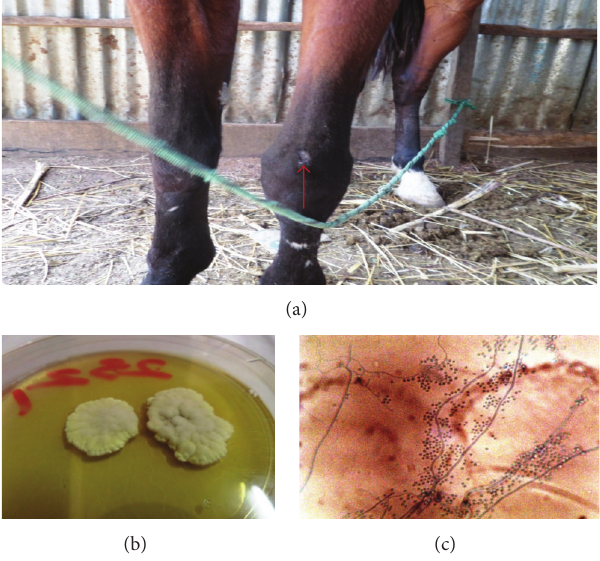
Figure 9: Lesion caused by T. mentagrophytes on the limb of a horse (a), granular colony of T. mentagrophytes (b), and typical microconidia of T. mentagrophytes “bunch of grapes” formation (c) (LCB × 400).